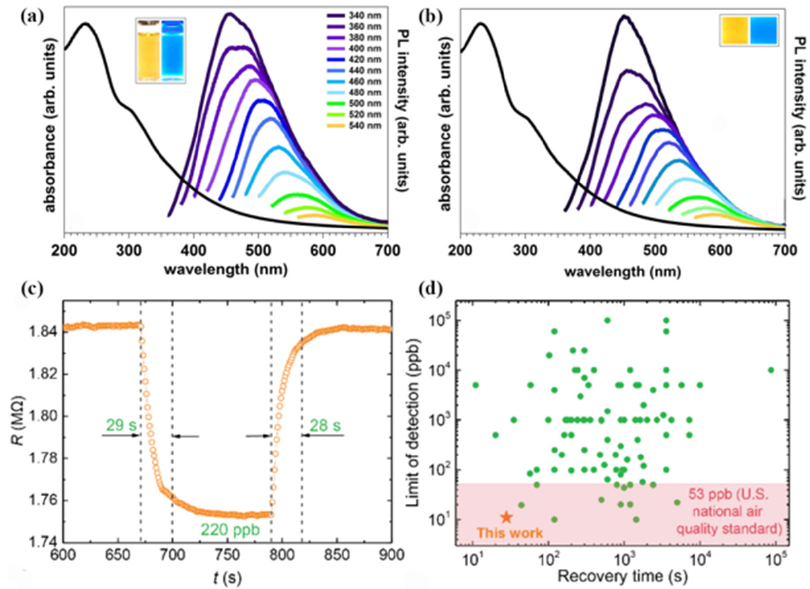
Figure 10. UV–Visible absorption spectra and photoluminescence measurements of ( a ) as-prepared graphene oxide QDs obtained from electrochemical etching in phosphate buffer solution and ( b ) graphene oxide QD-based nanospheres [60]. Copyright 2014, Carbon. ( c ) Response–recovery curve of the CdS gel sensor in the presence of 220 ppb of NO 2 . ( d ) Limit of detection and recovery time of CdS gel sensor [61]. Copyright 2020, Journal of the American Chemical Society .